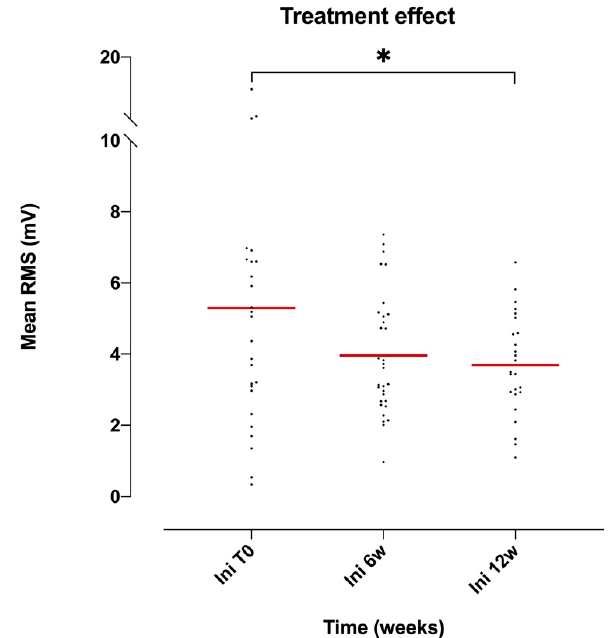
Figure 2. Scatter dot plot of the mean mRMS values of the RA muscle during the first three minutes of the session (Ini) in relation to the treatment time (T0: first session; 6 w: week 6; 12 w: week 12). Tukey multiple-comparison test: * ( p < 0.05).